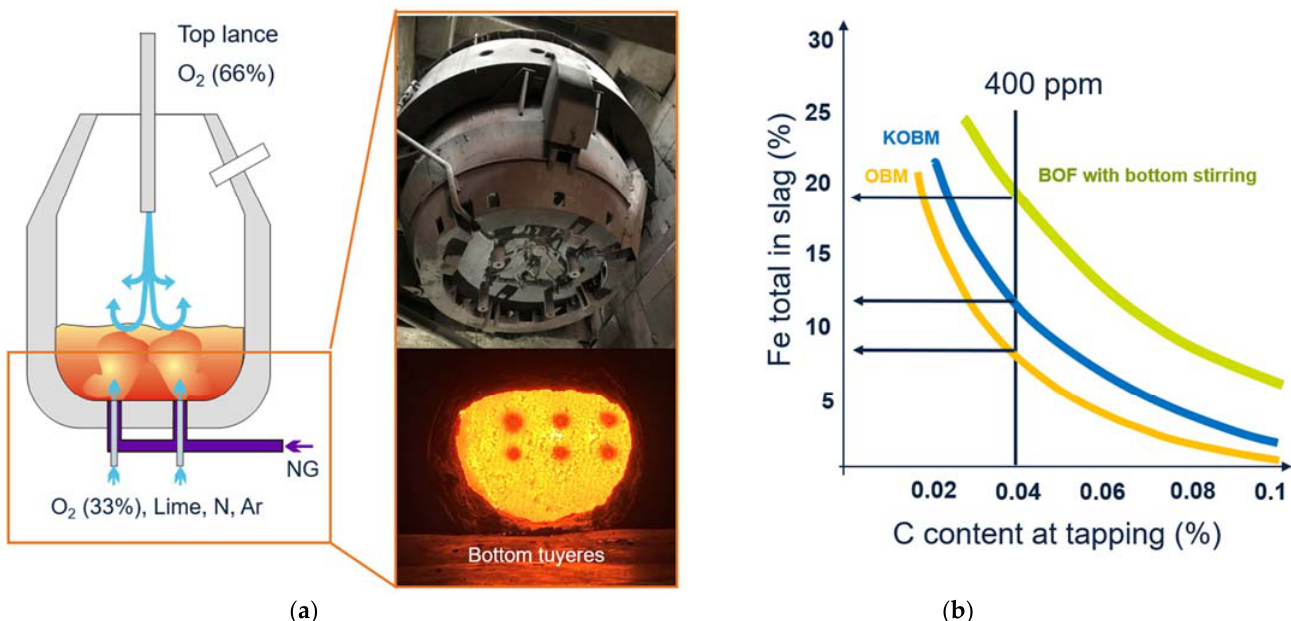
Figure 10. ( a ) KOBM converter with top and bottom blowing system and lime injection. ( b ) Total iron content in slag at certain carbon content at tapping for different converter processes: BOF process with top blowing and bottom stirring, KOBM with combined blowing, and OBM with oxygen bottom blowing